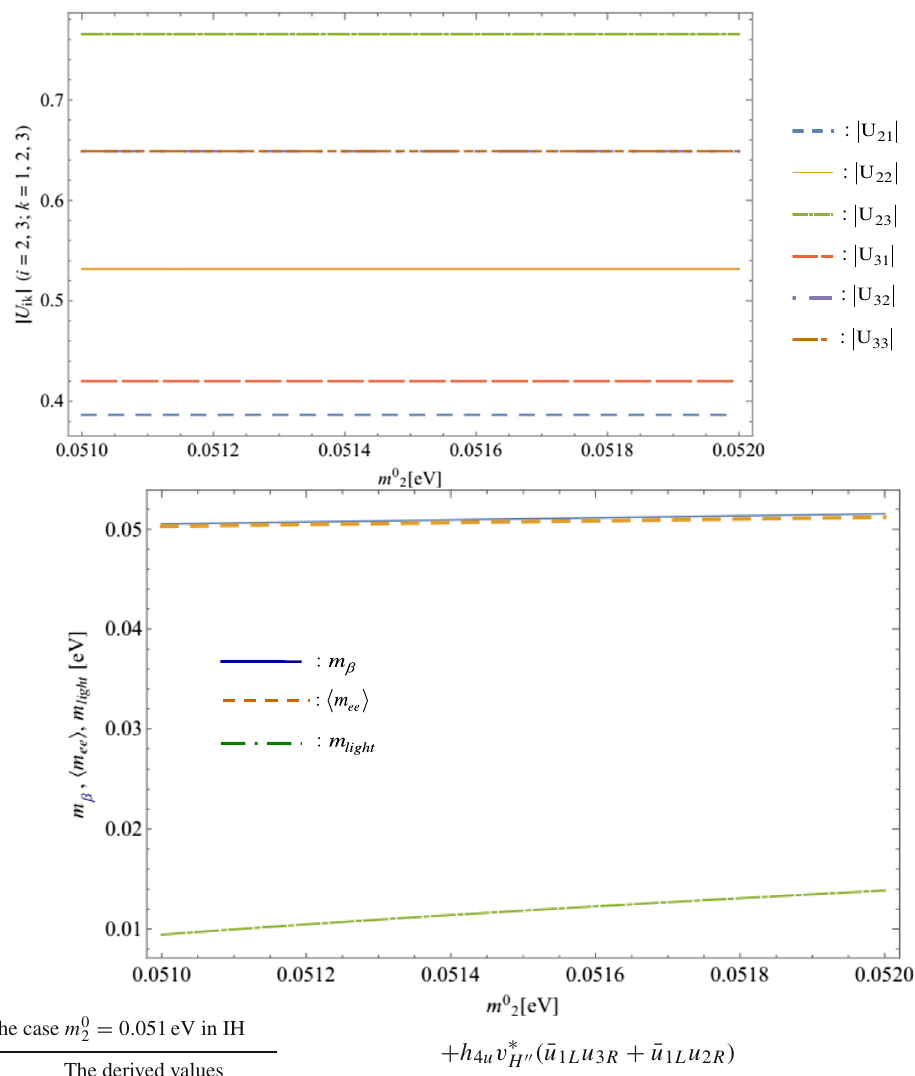
Fig. 3 | U | ( k = 2 , 3 ; j = 1 , 2 , 3 ) as ki functions of m 0 ∈ ( 0 . 051 , 0 . 052 ) eV in the m 0 2